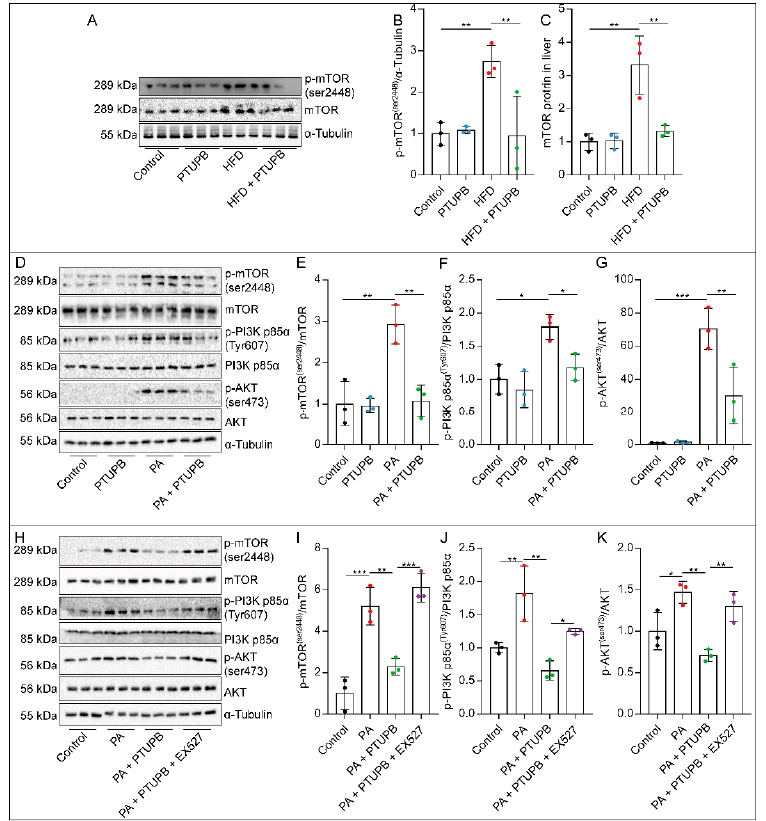
Figure 7. PTUPB inhibits the PI3K/AKT/mTOR signaling pathway by promoting Sirt1 expression. The mTOR protein and its phosphorylation level in the liver were measured by Western blot and